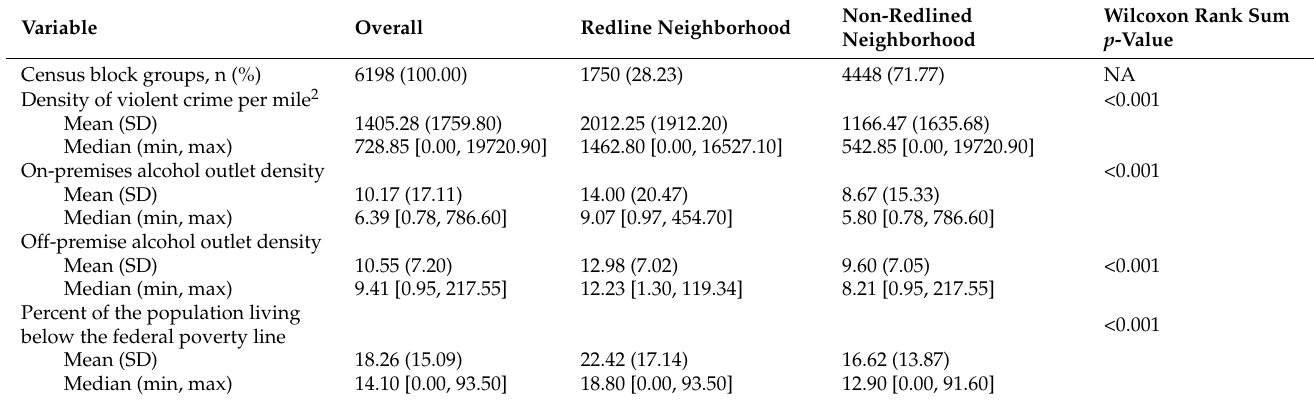
Table 1. Description of the Communities overall and by history of